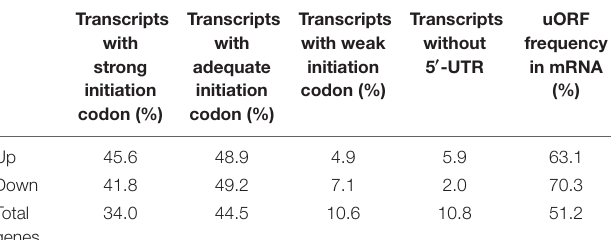
TABLE 9 | The frequency of initiation codon and uORFs for up-translated and down-translated genes in atgcn1-1 , compared with WT, under normal temperature